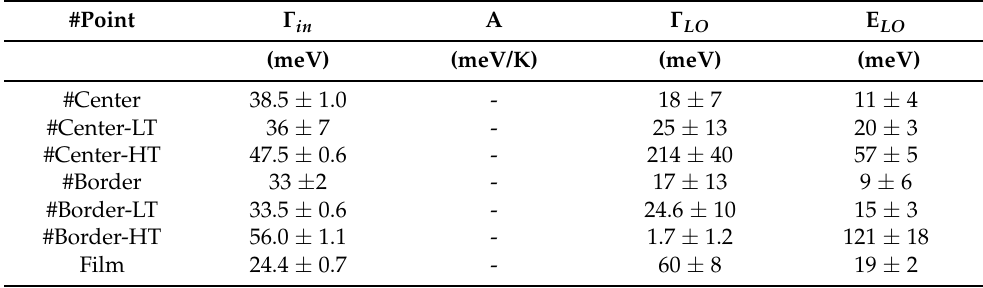
Table 1. Best fit values of the parameters extracted from the analysis of the temperature dependence of the FWHM of the two investigated points of the NC film and the bulk polycrystalline thin film. LT and HT are relative to the fit and represent low temperature and high temperature, respectively. #Point Γ in A Γ LO E LO (meV) (meV/K) (meV) (meV) #Center 38.5 ± 1.0 - 18 ± 7 11 ± 4 #Center-LT 36 ± 7 - 25 ± 13 20 ± 3 #Center-HT 47.5 ± 0.6 - 214 ± 40 57 ± 5 #Border 33 ± 2 - 17 ± 13 9 ± 6 #Border-LT 33.5 ± 0.6 - 24.6 ± 10 15 ± 3 #Border-HT 56.0 ± 1.1 - 1.7 ± 1.2 121 ± 18 Film 24.4 ± 0.7 - 60 ± 8 19 ±